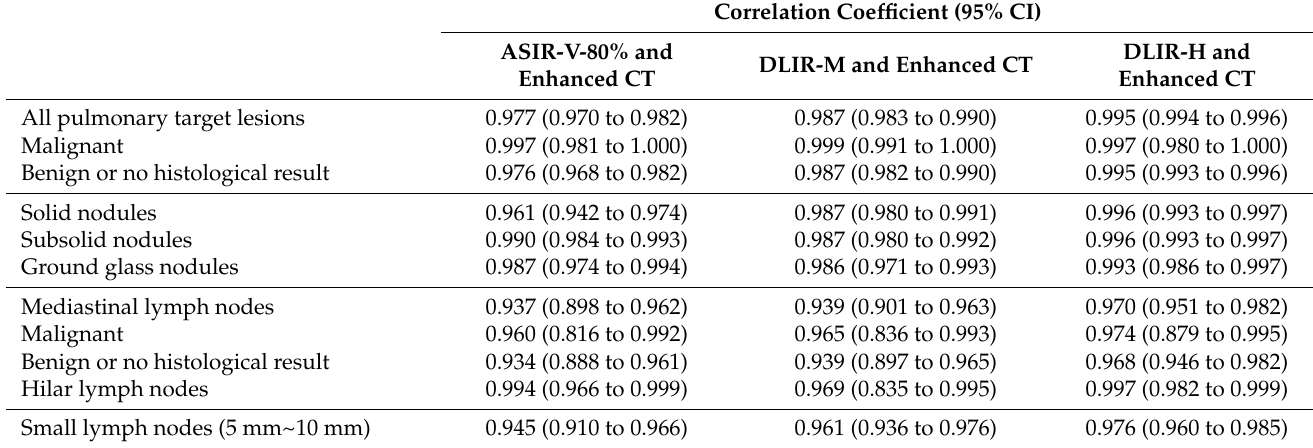
Table 4. Pearson’s correlation coefficients of measured diameters of RECIST-defined nonmeasurable lesions between ultra-low-dose CT and contrast-enhanced CT. Correlation Coefficient (95% CI) ASIR-V-80%